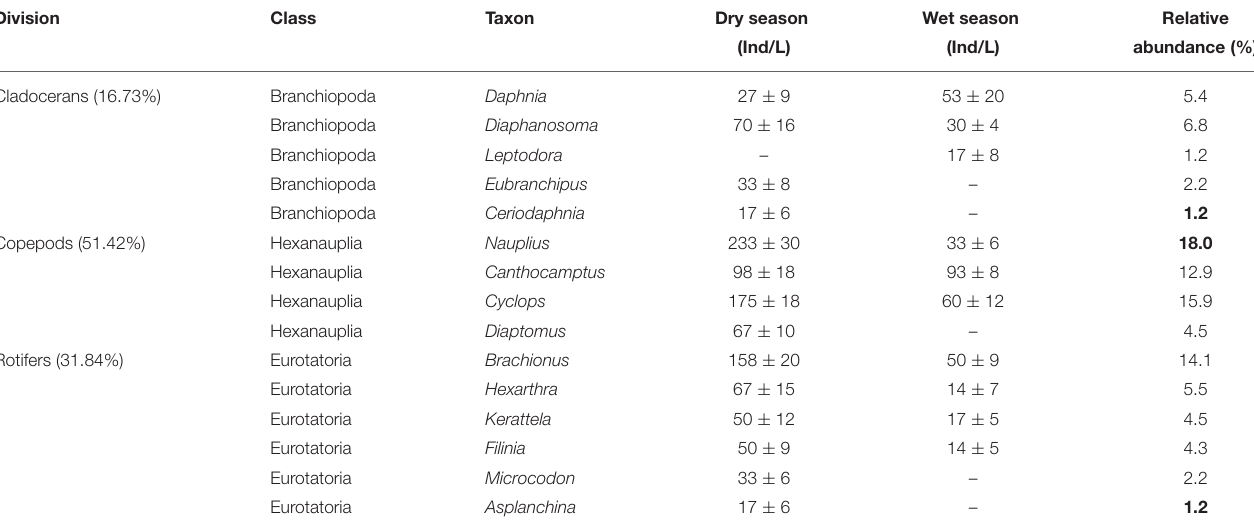
TABLE 4 | Mean abundance of zooplankton taxa recorded in Lake Kanyaboli from February 2020 to February